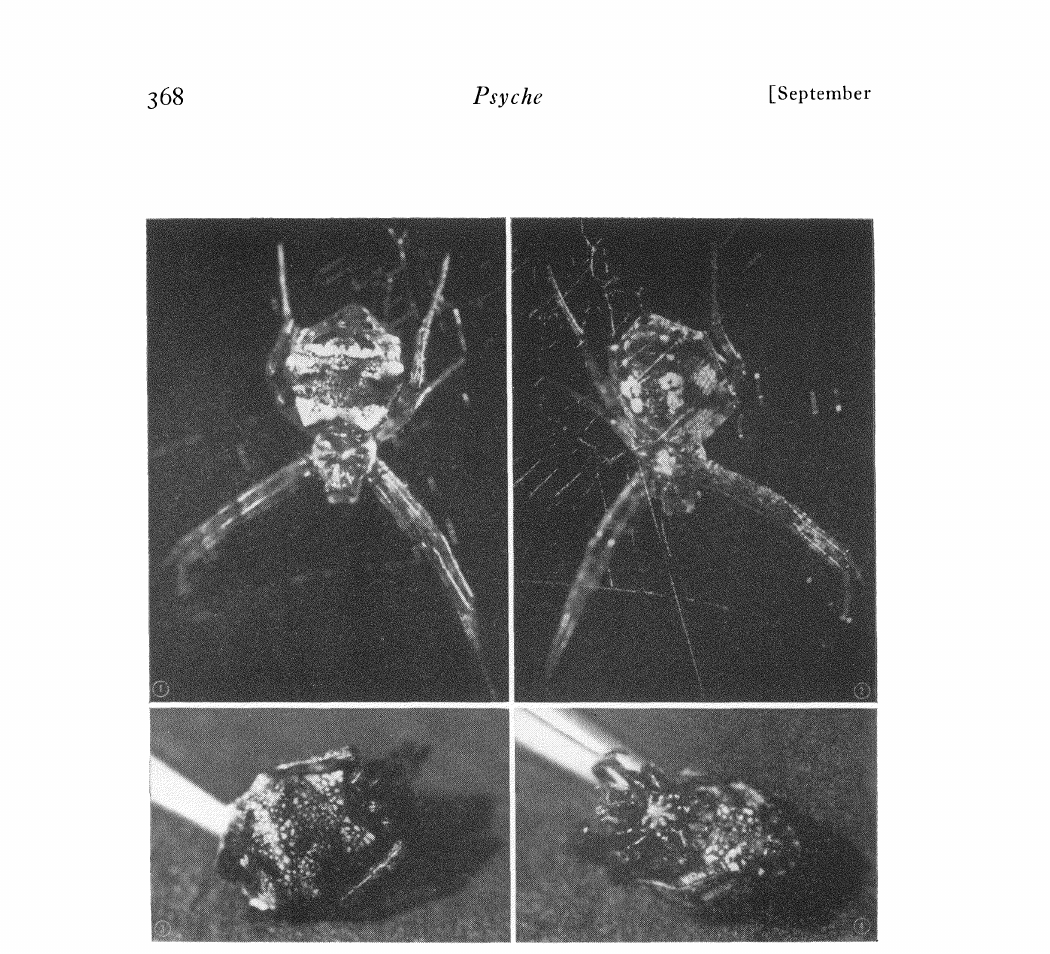
Figs. 1-4. Color change ,in Gea heptagon, total length of the spider’s body is bout 5.5 mm. 1. Dorsal view of female on web. 2. Ventral view of female on web. 3. Dorsal view o.f female after dropping from web. 4. Ventral view of female after dropping from